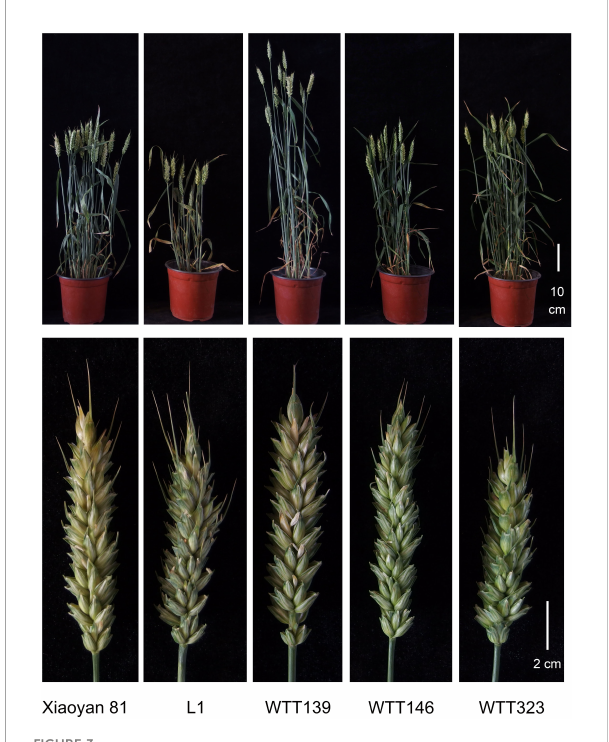
FIGURE 3 Phenotypic images of Xiaoyan 81 and four wheat – Th. ponticum 4Ag translocation